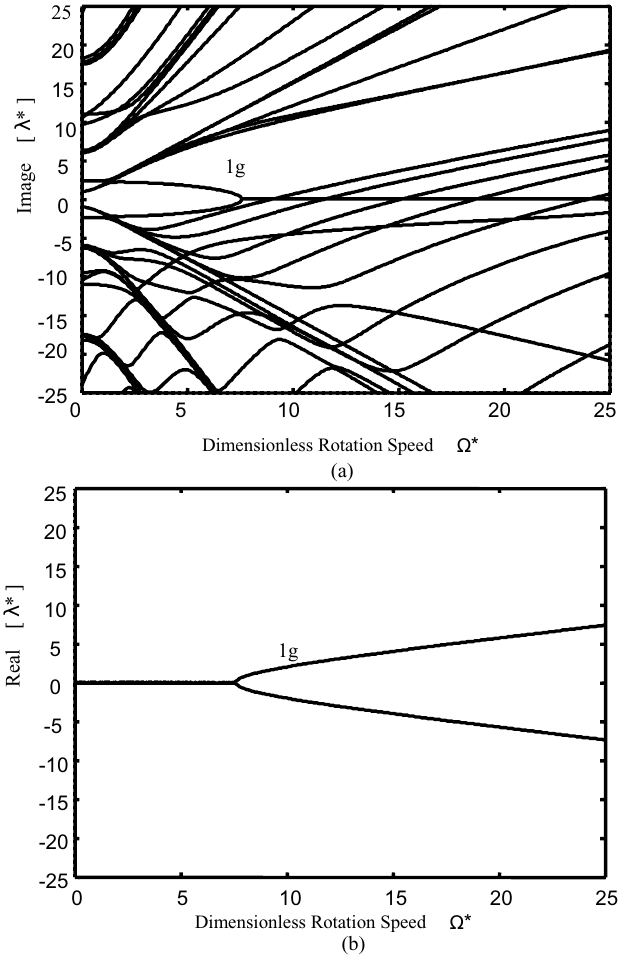
Fig. 10. Variation of eigenvalues with rotation speed for a mistuned six-blade